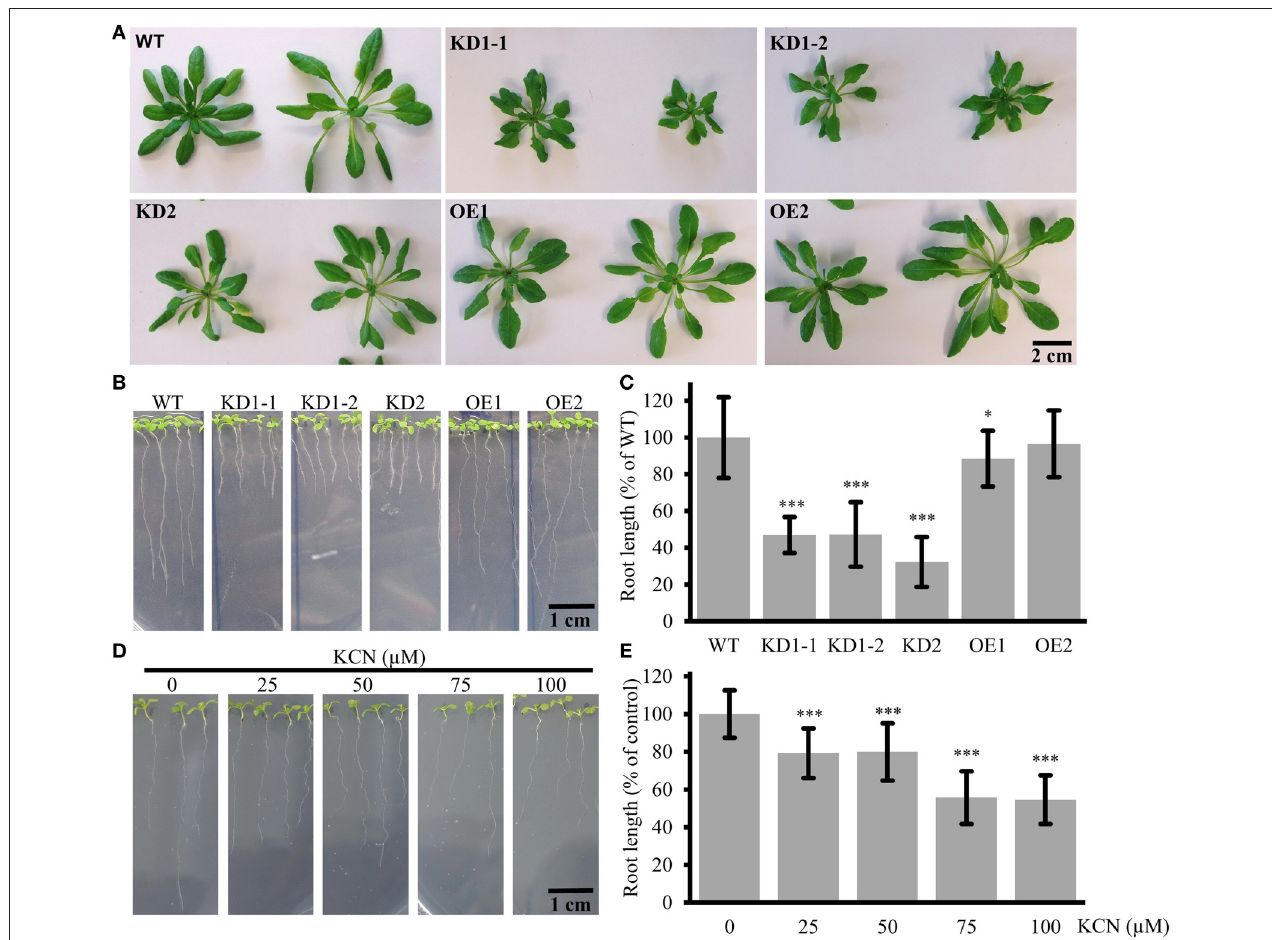
FIGURE 7 | Leaf and root phenotype of COX11 KD and OE mutants. (A) Rosettes from 7-week-old plants cultured under short-day conditions. In this experiment T4-generation KD1-1 plants were used (Supplementary Figure 2B). The scale bar applies to all panels. (B) Roots of 12-day-old seedlings. The scale bar applies to all panels (C) Root lengths from three independent experiments were measured and normalized to the WT ( = 100%). Error bars represent ± SD for n = 30 (WT, KD1-1, KD1-2, OE1, OE2), 16 (KD2). Asterisks indicate statistical significance calculated with the Student’s t -test ( * P < 0.05 ; *** P < 0.001 ) (D) WT roots grown in the presence or absence of KCN. The scale bar applies to all panels. (E) Root lengths from two independent experiments were measured and normalized to the untreated control ( = 100%). Error bars represent ± SD for n = 40 (0, 50, 100 µ M KCN), 30 (25, 75 µ M KCN). Asterisks indicate statistical significance calculated with the Student’s t -test ( *** P < 0.001 ). Absolute and normalized root lengths for (C,E) are given in Supplementary Table